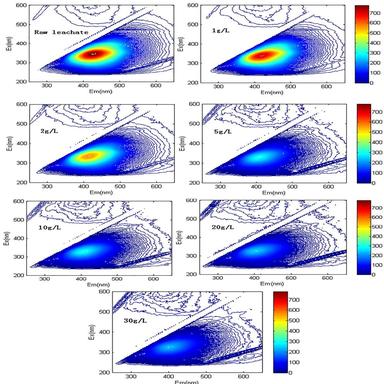
3D-excitation emission matrix fluorescence spectroscopy of landfill leachate treated with different dosage of AC and Ca (OH)2.